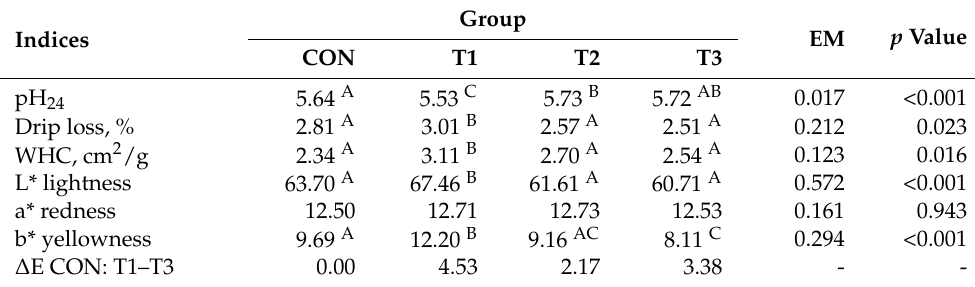
Table 4. Physico-chemical properties of breast muscles of male broiler